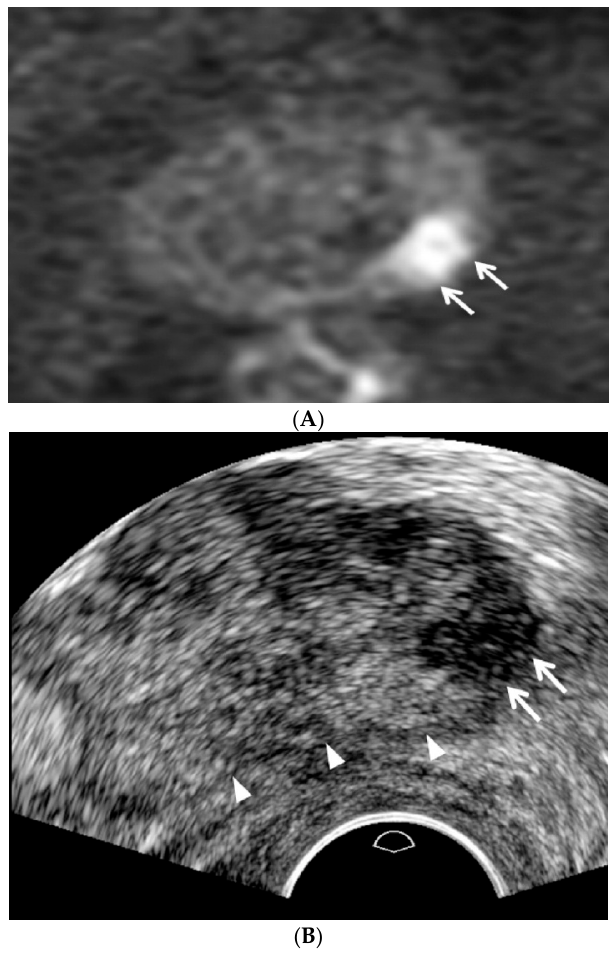
Figure 2. A PI-RADS 4 peripheral cancer in a 70-year-old man. ( A ) Diffusion-weighted axial MR image shows a hyperintense peripheral lesion (white arrows) in the left mid-gland measuring 1.3 cm, suggesting that the PI-RADS lesion category is 4. The patient’s PSA level was 3.56 ng/mL prior to biopsy. ( B ) TRUS axial image clearly shows a hypoechoic peripheral lesion (white arrows) in the left